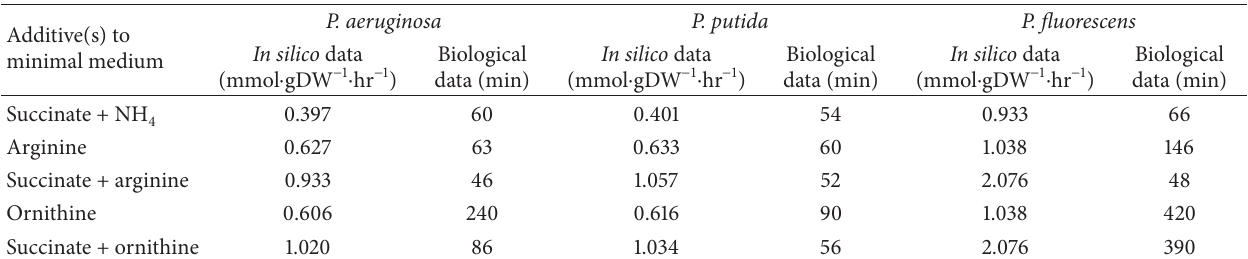
Figure 2: Benzoate degradation pathway. As depicted in the map, after benzoate uptake, cytoplasmic benzoate is converted to 1,6-dihydroxy- cis-2,4-cyclohexadiene-1-carboxylic. Since oxygen is one of the reactants, lowering the flux of oxygen uptake would in turn decrease the flux of this reaction, and the whole pathway would be less active, carrying lower flux values. This map shows only a part of metabolism. Table 1: Biological data and in silico results for arginine and succinate utilization of the bacteria and the models. Biological data represent doubling times and in silico results represent computational growth